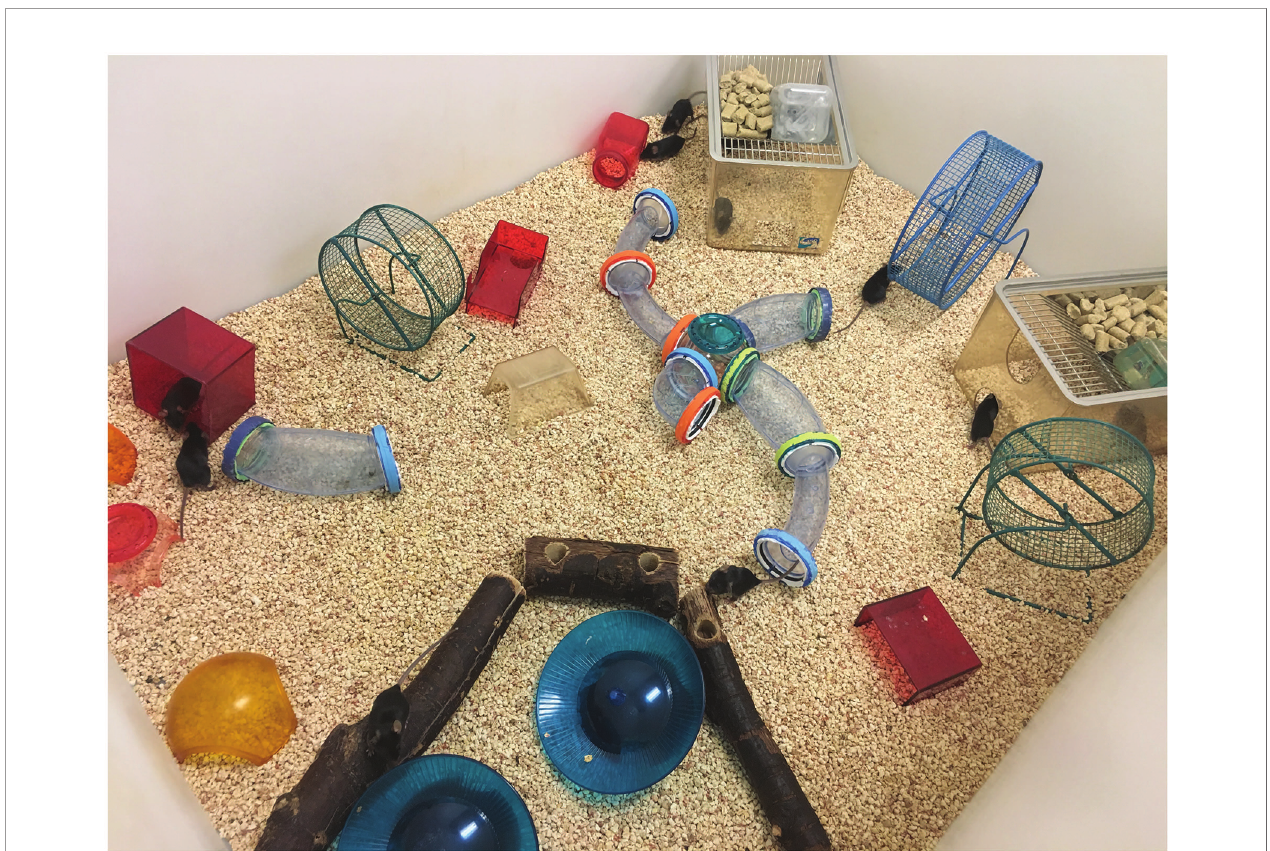
FIGURE 1 | A typical EE setting. The precise paradigm implemented in studies of EE varies both from lab to lab, but key features are generally similar. In contrast to standard housing, EE is a bigger cage supplemented with running wheels, tunnels, igloos, huts, retreats, wood toys, a maze, and nesting material. The supplements in EE cage are exchanged or rearranged once a week over the period of the